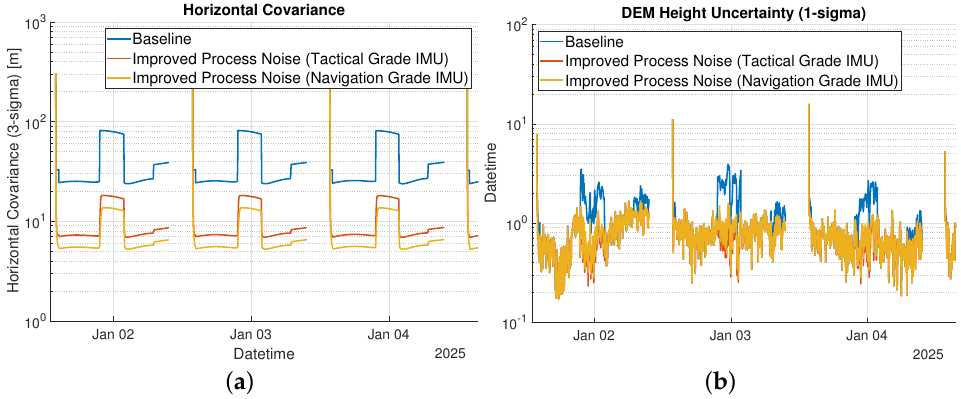
Figure 14. Performance of the LCNS position solution. ( a ) shows the horizontal (2D) covariance of for the different process noise scenarios identified in Table 12, while ( b ) shows the 1 σ uncertainty of the DEM measurement for the different process noise scenarios identified in Table